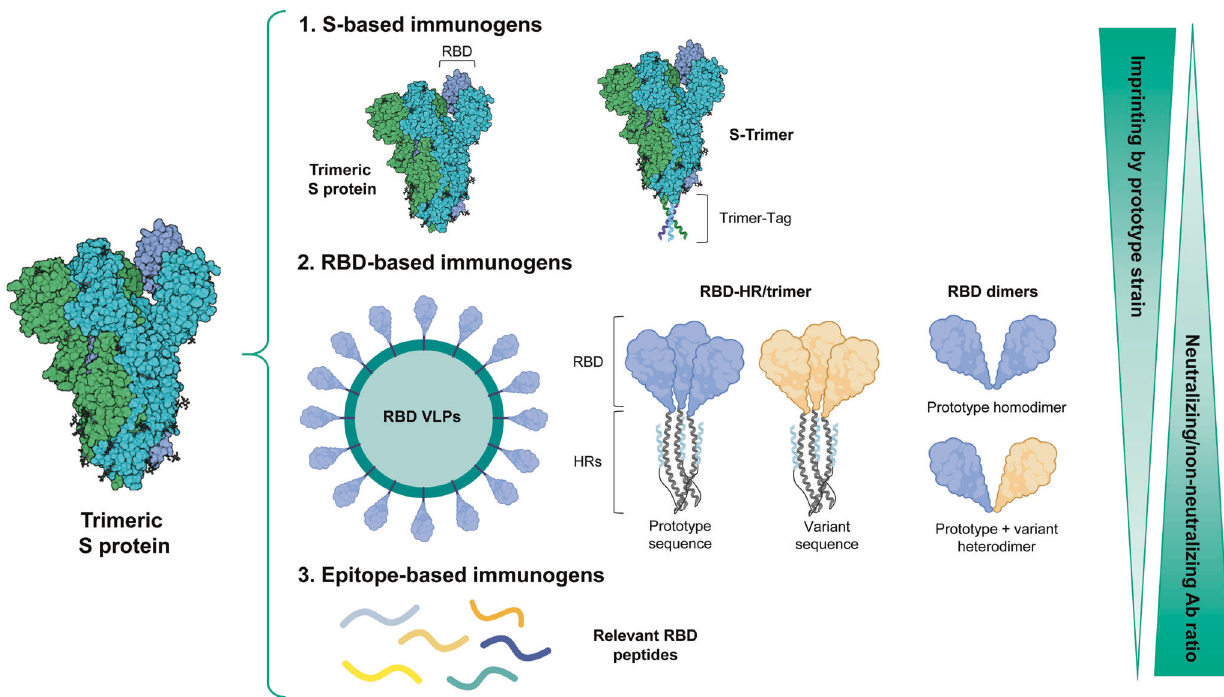
Fig. 1 Multimeric vaccine platforms against new SARS-CoV-2 variants. Based on the structure of the natural trimeric S protein, different immunogens have been designed: (1) Native or native-like S trimeric proteins, (2) RBD containing immunogens (multimerized RBD monomers presented on synthetic virus-like particles, RBD-HR/trimer-based vaccines containing trimers of RBD fused to HR1 and HR2 regions from SARS- CoV-2 S protein or RBD homo/hetero dimers), and (3) epitope based immunogens encompassing RBD neutralizing regions. These platforms may have different properties in terms of their immune imprinting from prototype variant and in the induced neutralizing/non-neutralizing antibody ratio (Created in